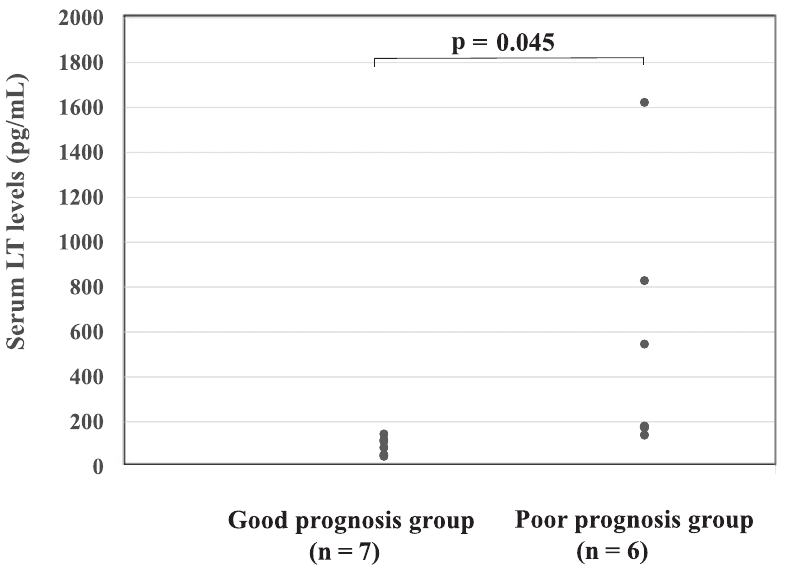
Figure 4. Comparison of the ser u m LT le v els meas u red at the end of the hospital sta y bet w een the g ood-pro g nosis g ro u p and the poor-pro g nosis g ro u p. The 13 children w ith RS V lo w er respirator y tract infection w itho u t recei v in g LTRA-treatment w ere di v ided into t w o g ro u ps, namel y , the g ood-pro g nosis g ro u p and the poor-pro g nosis g ro u p, j u d g ed u ntil April 2014, that is, bet w een 3 and 6 y ears after the start of the st u d y . Six s u bjects w ho w ere dia g nosed/ s u spected as ha v in g bronchial asthma b y a pediatrician w ere classified into the poor-pro g nosis g ro u p, and 7 s u bjects w itho u t bronchial asthma w ere classified into the g ood-pro g nosis g ro u p. LT, le u kotriene; RS V , respirator y s y nc y tial v ir u s; LTRA, LT receptor anta g